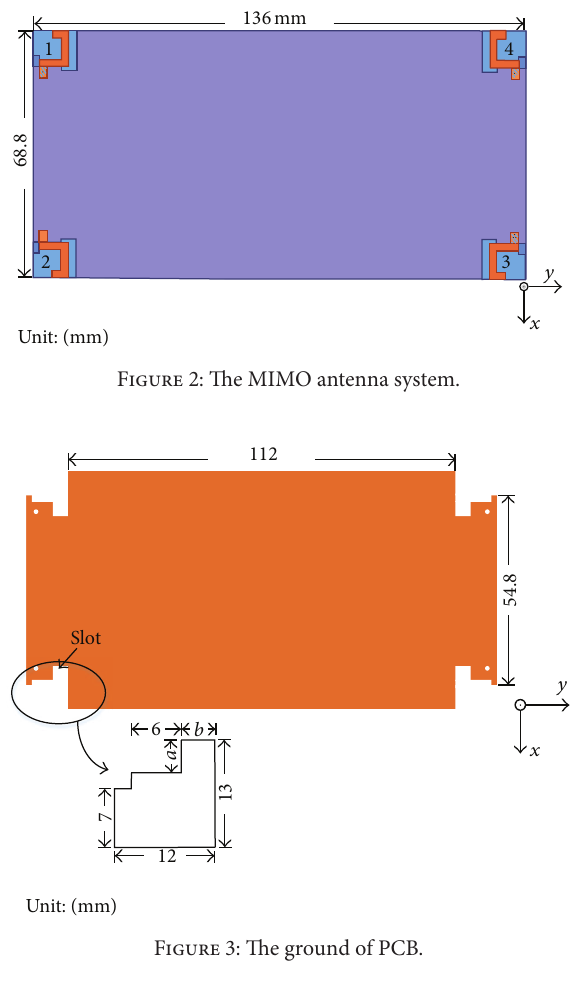
Figure 3: The ground of PCB.